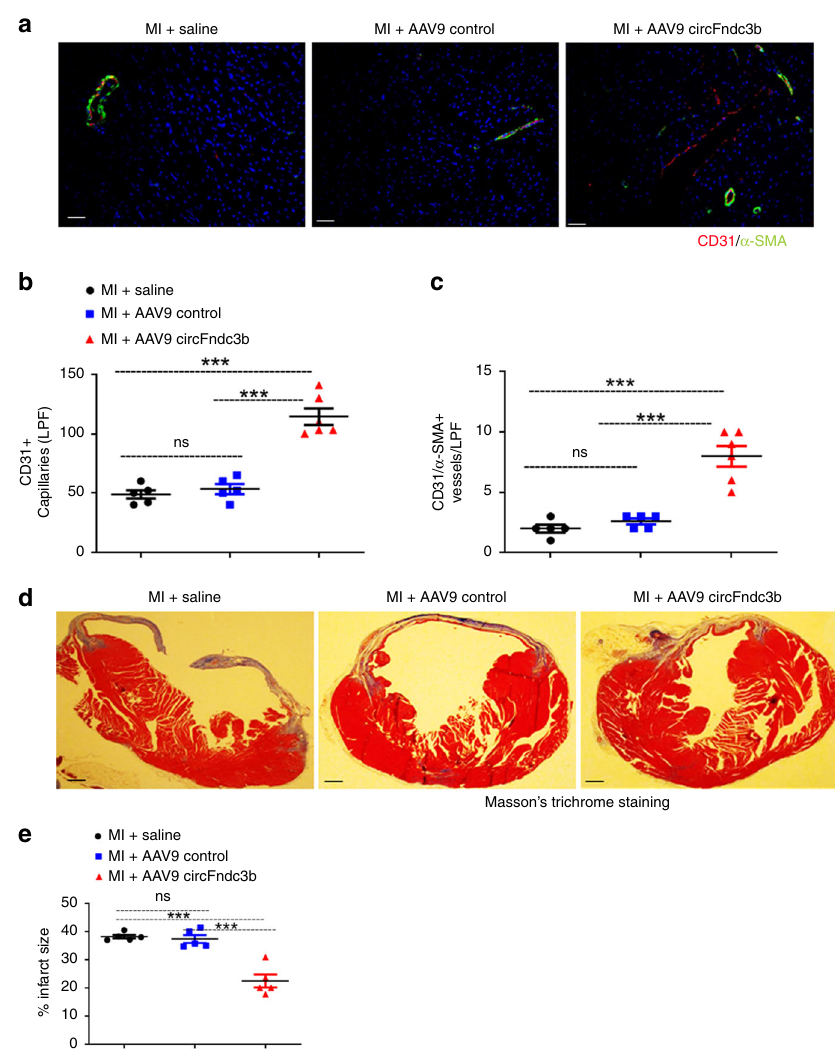
Fig. 5 AAV9 mediated overexpression of circFndc3b enhances neovascularization and reduces fi brosis after MI in mice: a Representative images of capillary density and arterioles measured in border zone of LV infarct at 8 weeks post-MI in AAV9 control or AAV9 circFndc3b or saline treated hearts. Capillaries were stained with CD31 + (red) and arterioles stained with α -SMA (green) and nuclei were counterstained with DAPI (blue). (Scale bar 100 μ m); b , c Quanti fi cation of border zone capillary number and arterioles across treatments presented as the number of CD31 + positive capillaries, α -SMA + arterioles and DAPI-stained nuclei per low power fi eld (LPF). n = 5 mice/each group. *** p < 0.001 vs AAV9 control or saline treated hearts (one- way ANOVA); ( d Representative images of Masson ’ s trichrome stained heart sections in the saline or AAV9 control or AAV9 circFndc3b treated hearts at 8 weeks post-MI; e Quantitative analysis of infarct size at 8 weeks post-MI in saline or AAV9 control or AAV9 circFndc3b treated hearts; n = 5 mice/each group. *** p < 0.001 vs AAV9 control or saline treated hearts (one-way